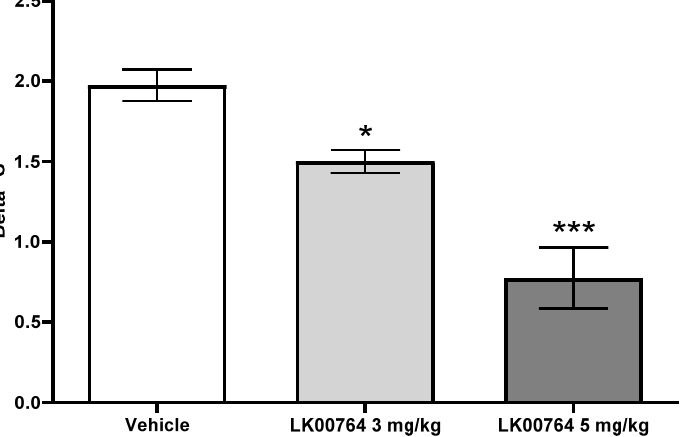
Figure 7. Effect of compound 62 (LK00764) on stress ‐ induced hyperthermia in rats (3 and 5 mg/kg, i. p., n = 8 per group); * p < 0.05, *** p < 0.05, Dunn’s test. i.p., n = 8 per group); * p < 0.05, *** p < 0.05, Dunn’s